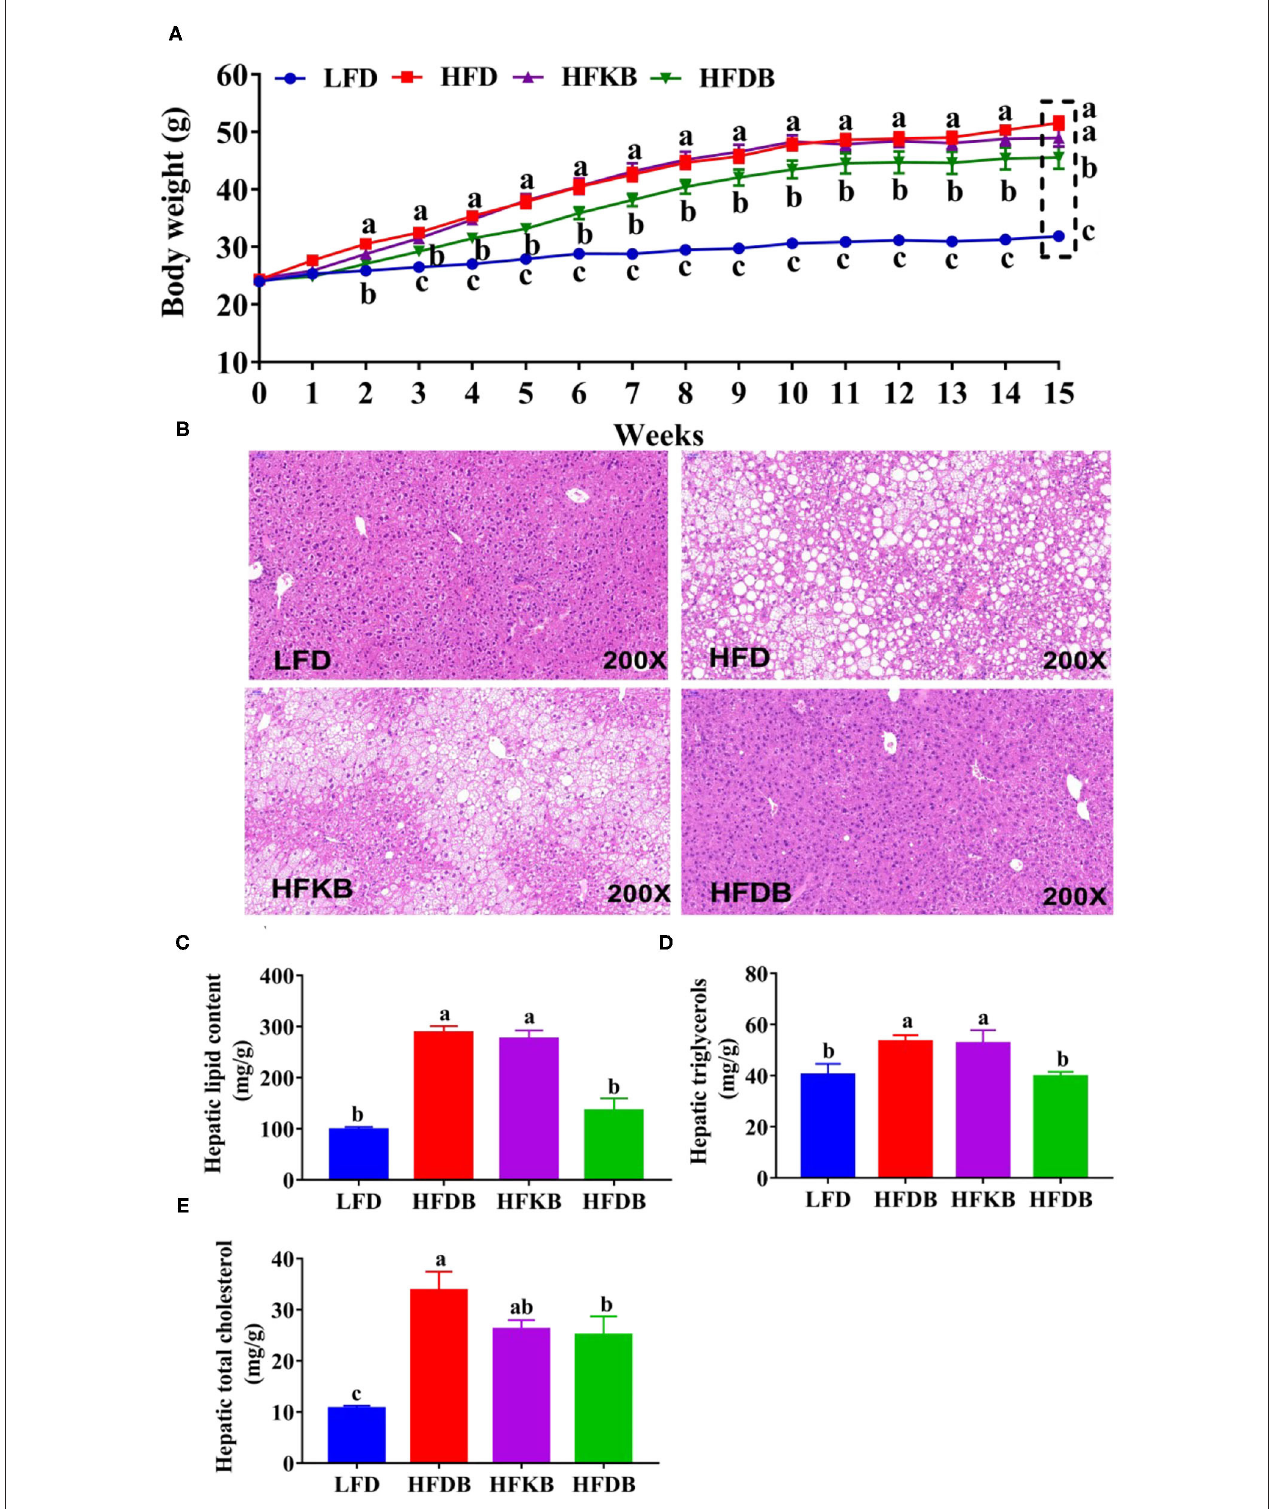
FIGURE 2 | Effects of black tea on body weight and fat accumulation in the liver. LFD, low-fat diet; HFD, high-fat diet; HFKB, HFD + KBT diet (containing 2.0% Keemun black tea); HFDB, HFD + DBT diet (containing 2.0% Dianhong black tea). (A) body weight; (B) hematoxylin and eosin–stained slices of liver; (C) total lipid content in the liver; (D) hepatic triglyceride content; (E) total cholesterol content in the liver. Data are presented as mean ± SEM ( n = 12). a,b,c p represents significant differences among groups (ANOVA, p < 0.05).